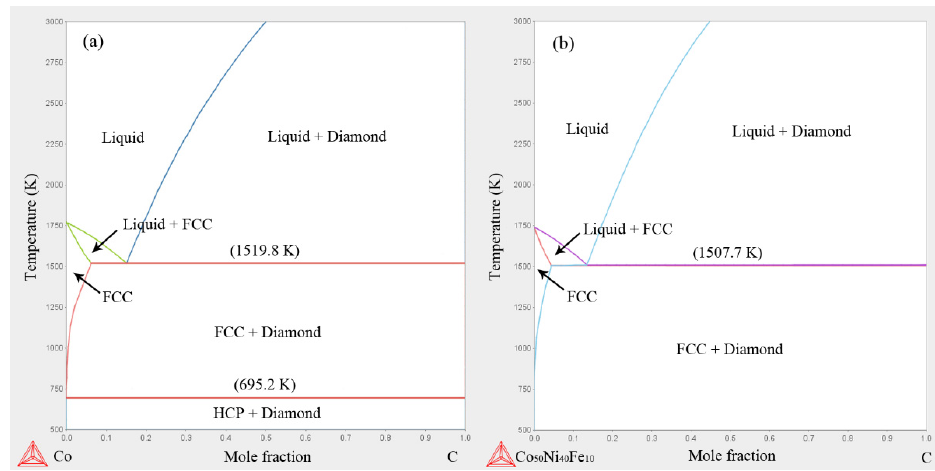
Figure 10. Phase diagrams at 6 GPa calculated by thermo-calc: ( a ) Co-C; ( b ) Co 50 Ni 40 Fe 10